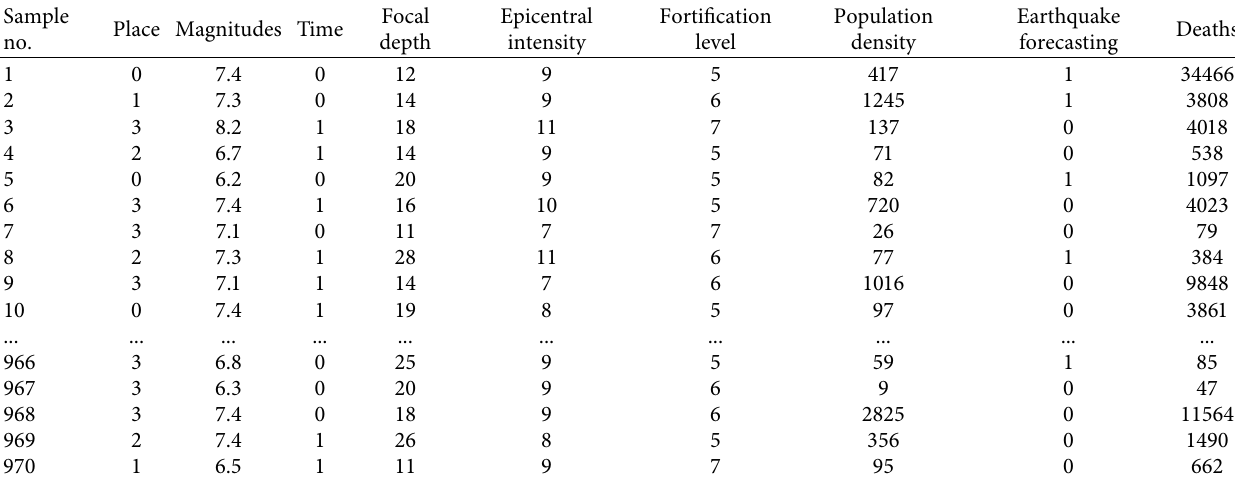
Table 5: Some desktop walkthrough data.